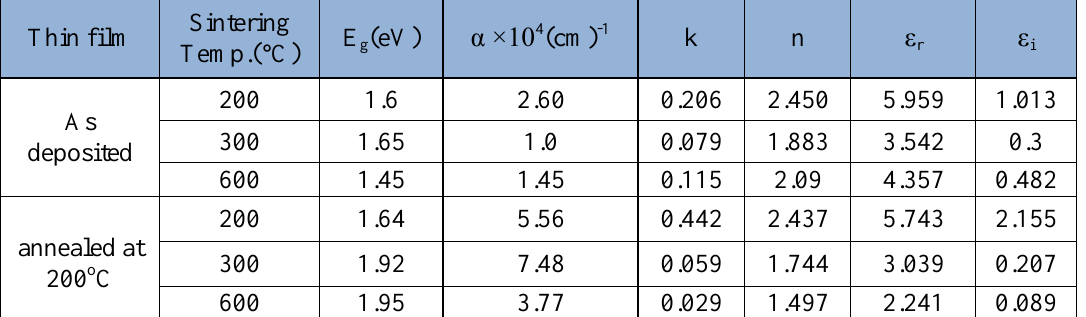
Fig.14: The variation of extinction coefficient (k) with wavelength (λ) of Ag sintered at different temperature (a) as deposited (b) annealed at 200 °C for half an hour.